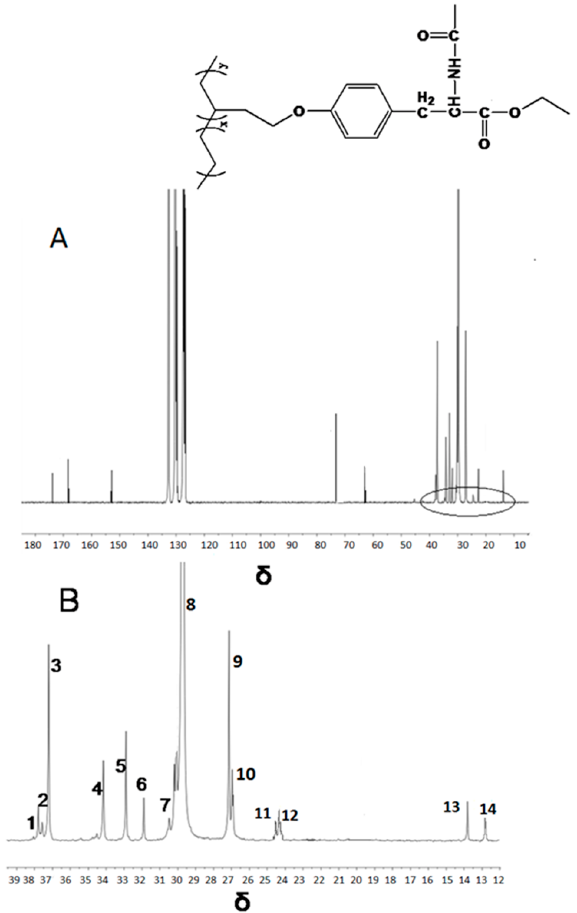
Figure 5. High-temperature solution 13 C NMR spectra ( A ); and expandedview ( δ = 10–40 ppm) ( B ) of the copolymer of ethylene/ N -acetyl- O -(but-3-enyl)- L -tyrosine ethyl ester with comonomer insertion ratio 2.24 mol % from run 3 in Table 1. Table 2. 13 C NMR data of carbon atoms on the copolymer of ethylene and N -acetyl- O -(but-3-enyl)- L -tyrosine ethyl ester.